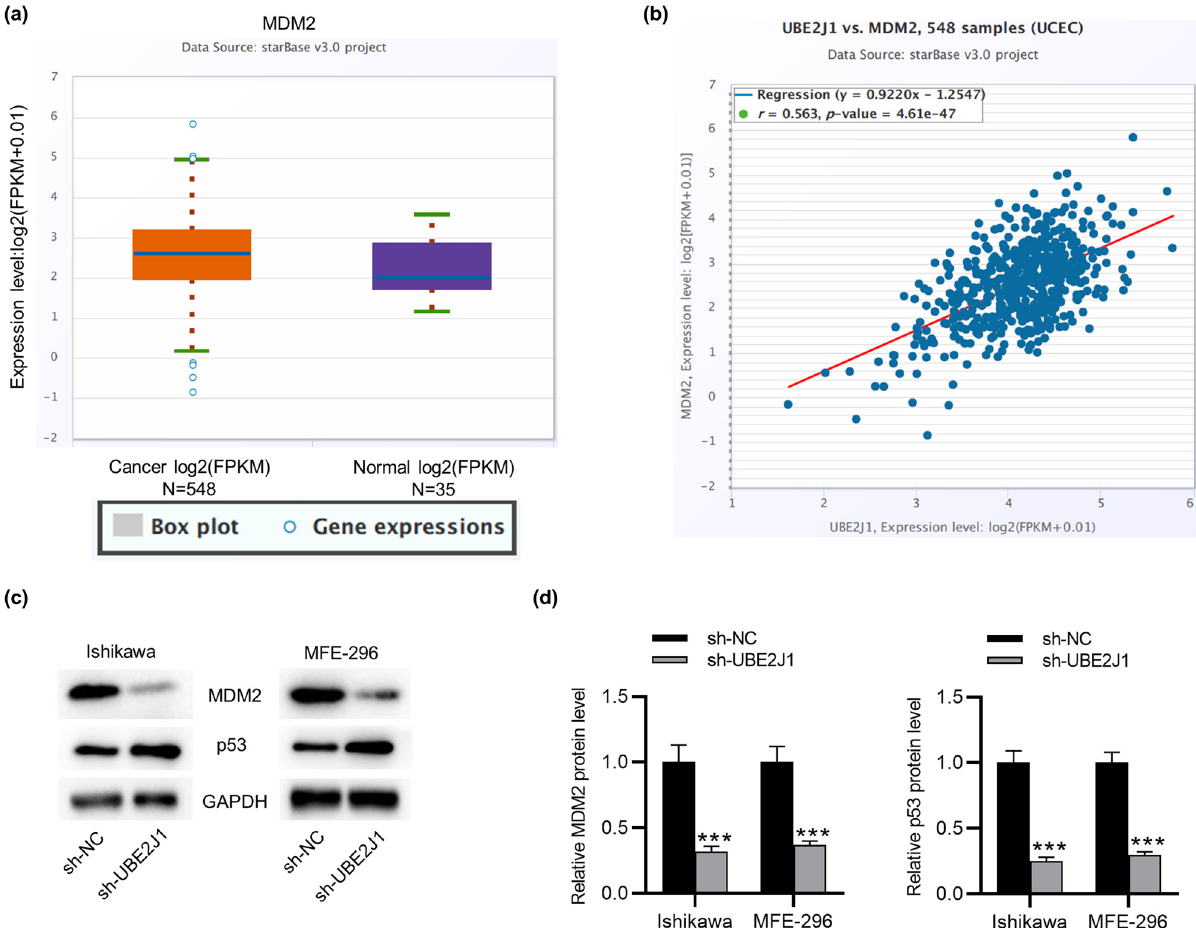
Figure 4: UBE2J1 positively modulates the expression of MDM2. ( a ) MDM2 expression in 548 EC tissues and 35 normal samples is shown on ENCORI website. ( b ) ENCORI website shows the correlation between MDM2 expression and UBE2J1 expression. ( c and d ) Western blot analyses were conducted to measure the protein levels of MDM2 and p53 in EC cells transfected with sh - UBE2J1. Bar graphs were used to represent the data. *** p <